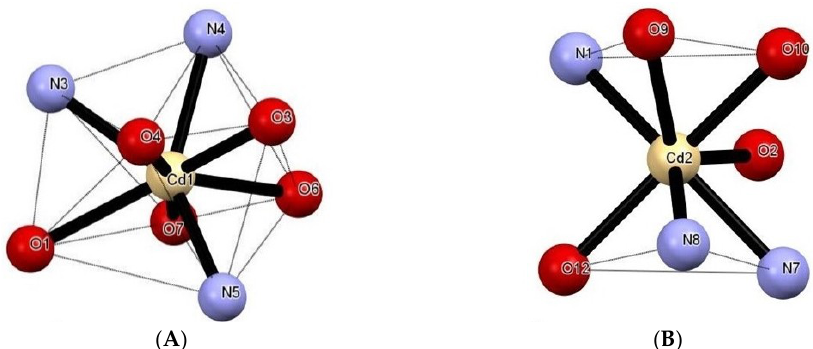
Figure 1. Anisotropic displacement ellipsoid diagram of 1 with a view of coordination environments around Cd1 and Cd2 centers. Thermal ellipsoids are at 30% probability. N5 atom was generated by a symmetry operator (−1+ x , + y , −1+ z ).